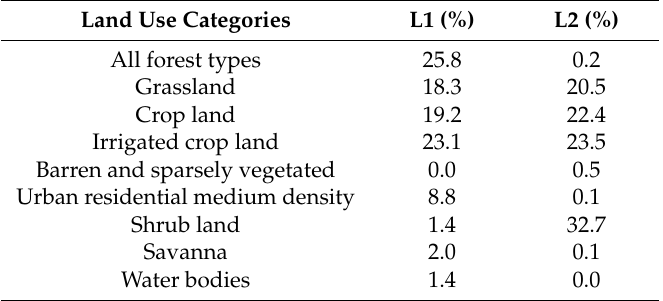
Table 2. Percentage of area in each category of two land use maps after being fed into Soil and Water Assessment Tool (SWAT).